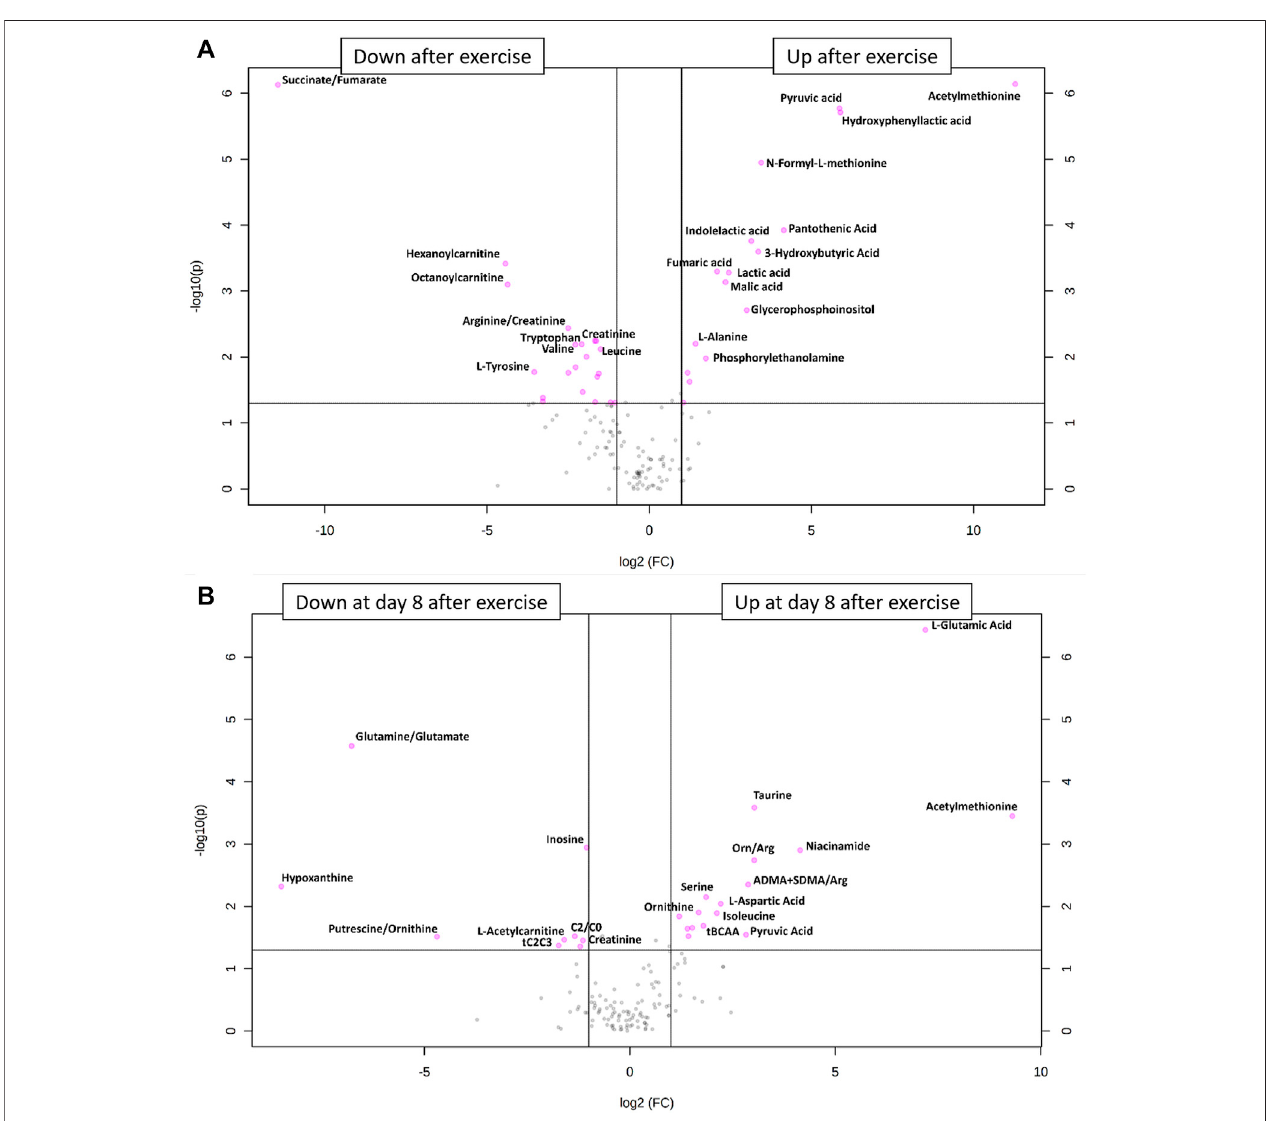
FIGURE3|(A) Volcanoplotofallmetabolitealterationsintheshort-term (A) andonday8afterexercise (B) showingtherelationshipbetweenfoldchange(log2fold change (FC); horizontal axis)) and signi fi cance ( − log10 ( p value); vertical axis), respectively. Fold changes describe alterations comparing post- to pre-exercise, using a cut-off point of p ≤ 0.05 and a FC ≥ 2. Metabolites shown as pink points indicate metabolites that were signi fi cantly down- or upregulated after (A) or on day 8 after (B) exercise, respectively.